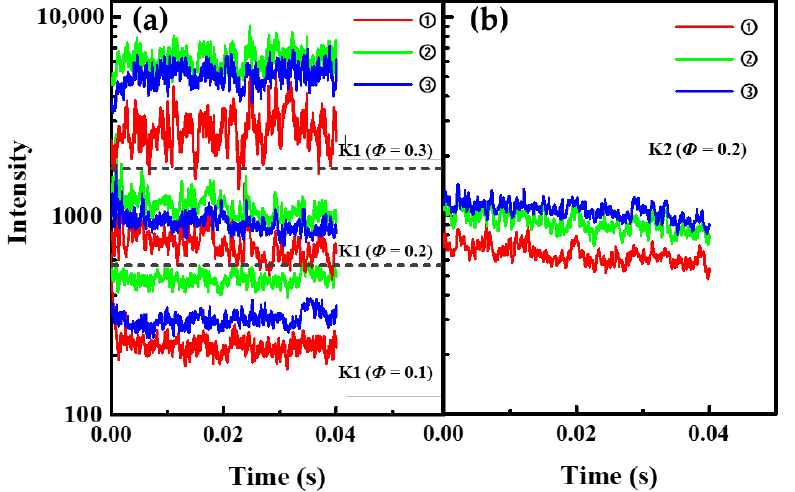
Figure 10. Averaged chemiluminescence intensity in different regions of the cavity with ( a ) the K1 injector and ( b ) the K2 injector.